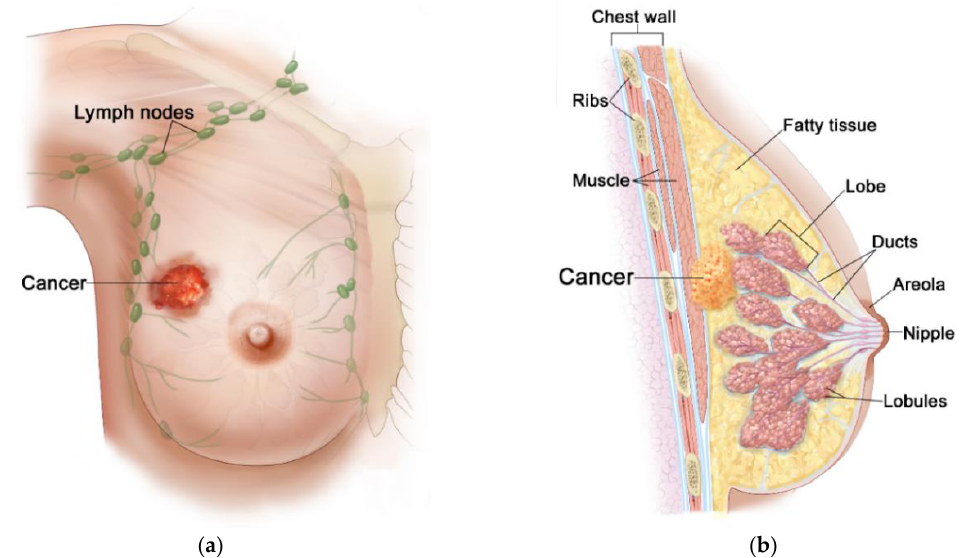
Figure 2. Anatomical view of female breast including tumor inside: ( a ) front view; ( b ) sectional view. Reproduced with kind permission from 2012 Terese Winslow LLC. Adapted from [44].